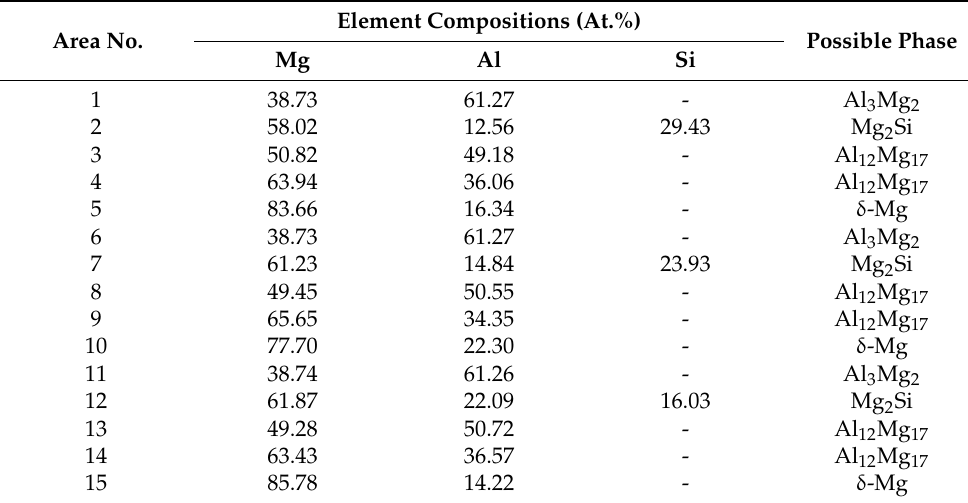
Table 1. Results of EDS analysis at different locations in Figure 4. Area No.